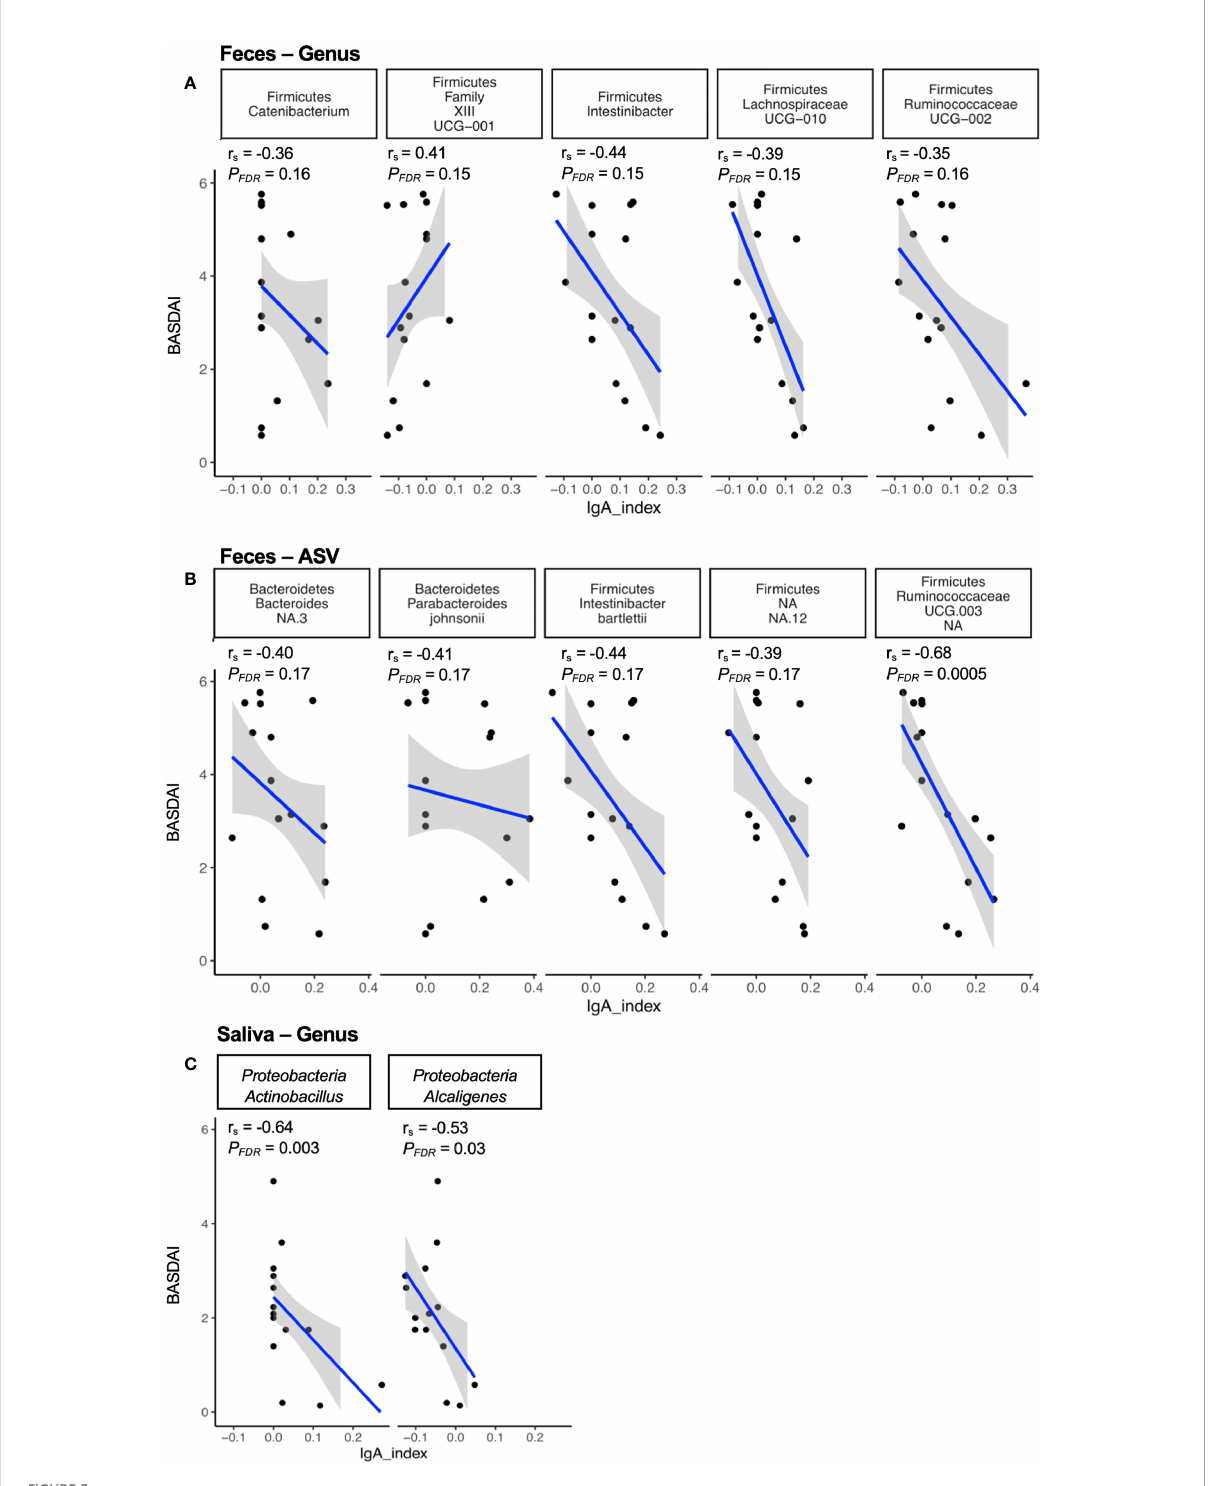
FIGURE 3 Correlation of immune reactive microbes with disease activity. The IgA index of the immune reactive microbes is correlated with the disease index (BASDAI score) at the genus (A) and ASV (B) level for fecal microbes, and at the genus (C) level for salivary microbes. The strength of each linear association is measured with a correlation coef fi cient r. The value of r=1 indicates perfect correlation; a positive value denotes a positive correlation and a negative value signi fi es an inverse correlation. In addition, the adjusted p-value (PFDR) of the correlations after multiple tests correction are also depicted on the